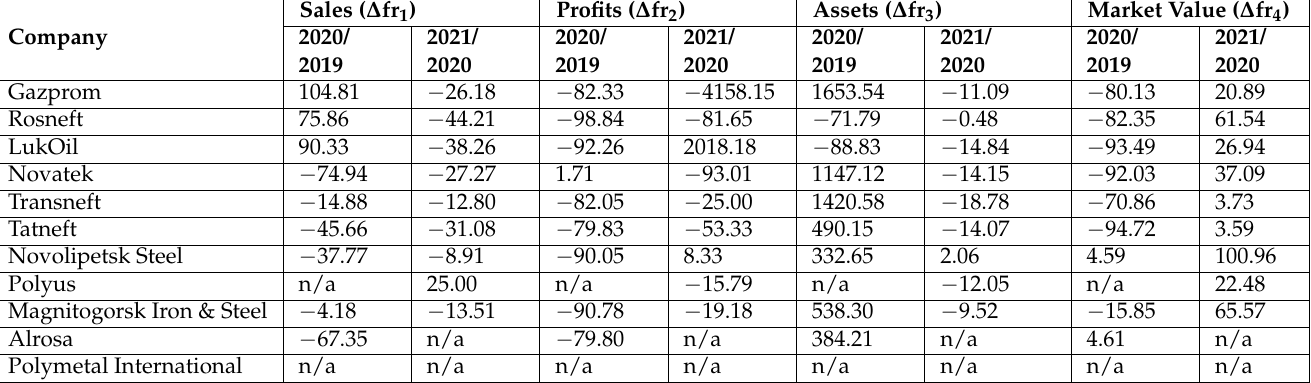
Table 2. The change in the financial indicators of companies in 2020 compared with 2019, and in 2021 compared with 2020 is shown. Table 2. Assessment of the financial risks of Russian companies in the 2020–2021 period, %.